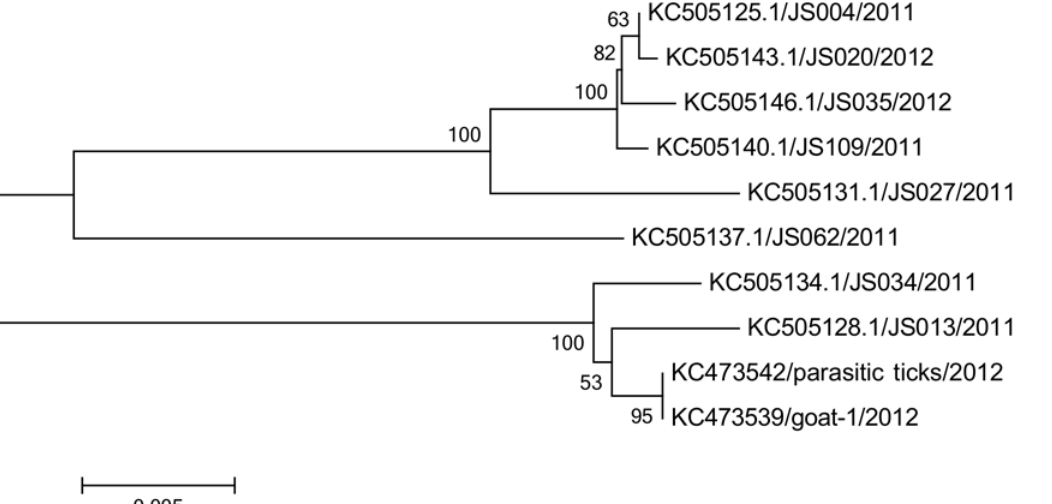
Fig 6. Phylogenetic analysis of genetic small segments of severe fever with thrombocytopenia syndrome virus (SFTSV) isolated from one infected goat and its parasitic ticks ( H . longicornis ) sample in this study, and from SFTS patients in 2011 – 2012. The tree was constructed by using the neighbor-joining method with MEGA 5.05. Scale bar indicates nucleotide substitutions per site.